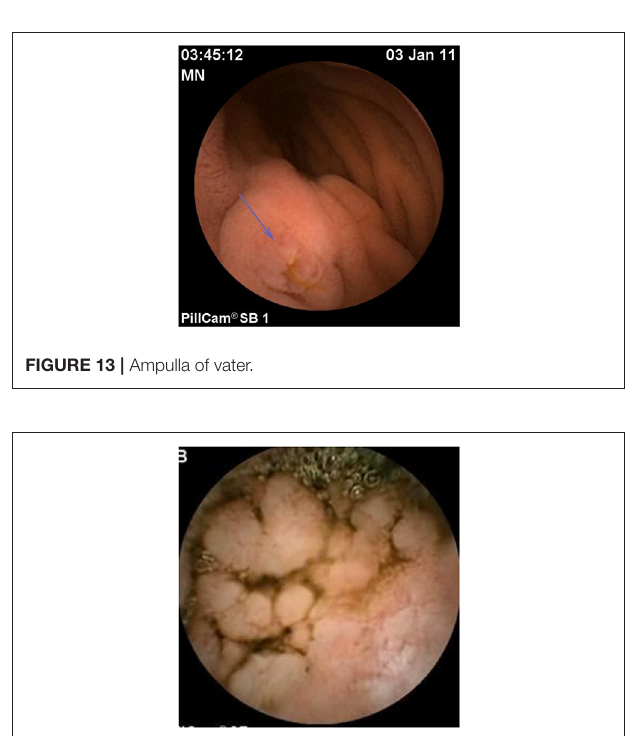
FIGURE 11 | Lymphangiectasia (extensive).